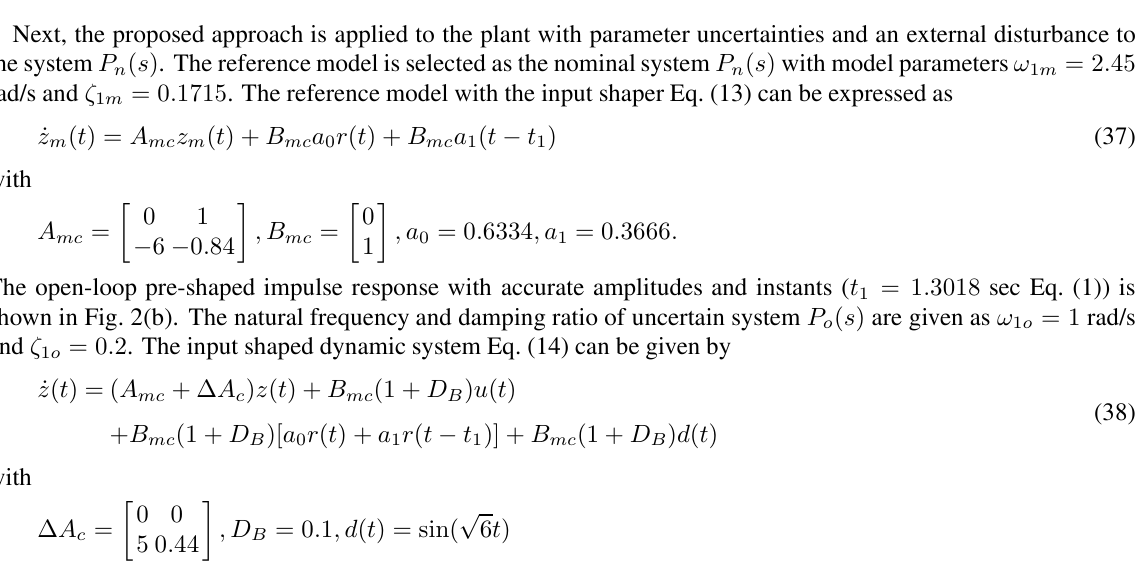
Fig. 2. (a) Impulse response of the model to the shaped input [20] (b) Response with exact cancellation (c) Response with parameter variations and external disturbance (d) Output